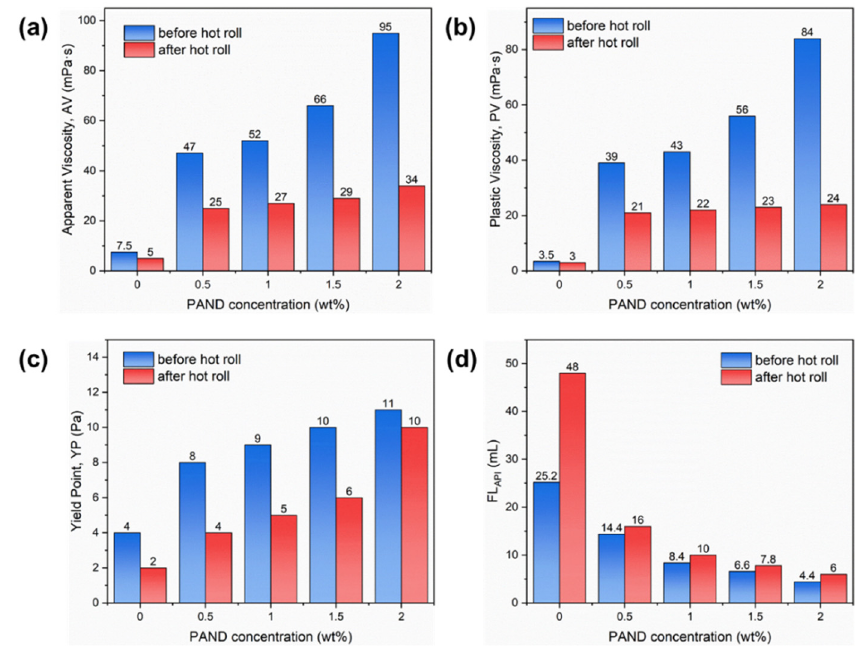
Figure 4. Rheological and fluid loss properties of drilling fluid with different contents of PAND before and after aging at 180 °C for 16 h: ( a ) apparent viscosity (AV); ( b ) plastic viscosity (PV); ( c ) yield point (YP); ( d ) fluid loss volume (FL API ).